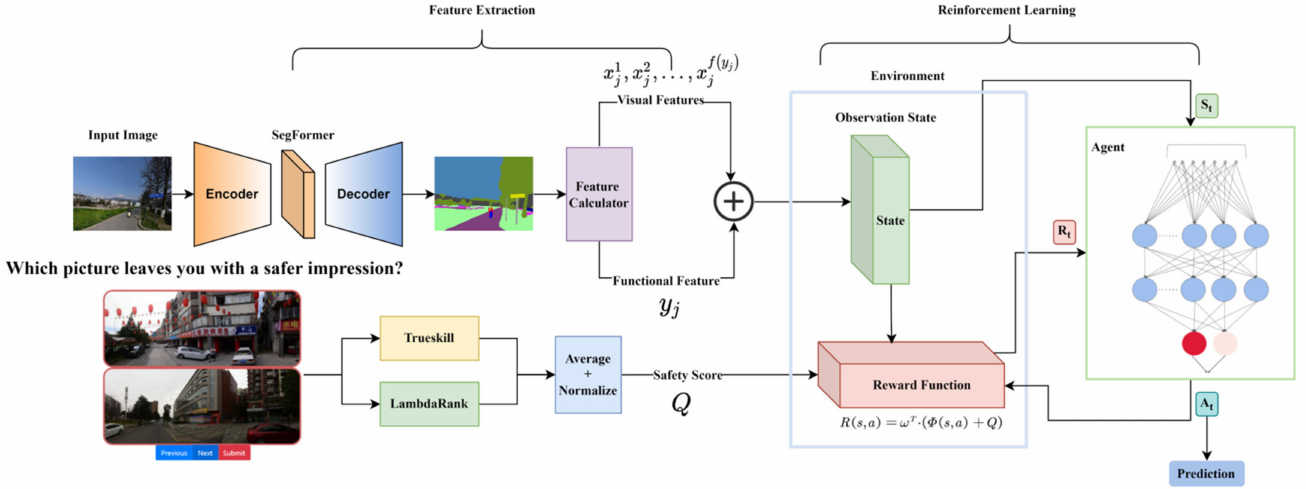
Figure 1. The proposed decision-making framework for urban-safety perception prediction consists of two main modules: a feature-extraction module to extract visual semantic and functional features, as well as safety score obtained from crowdsourcing; and a reinforcement learning module to obtain the safety perception